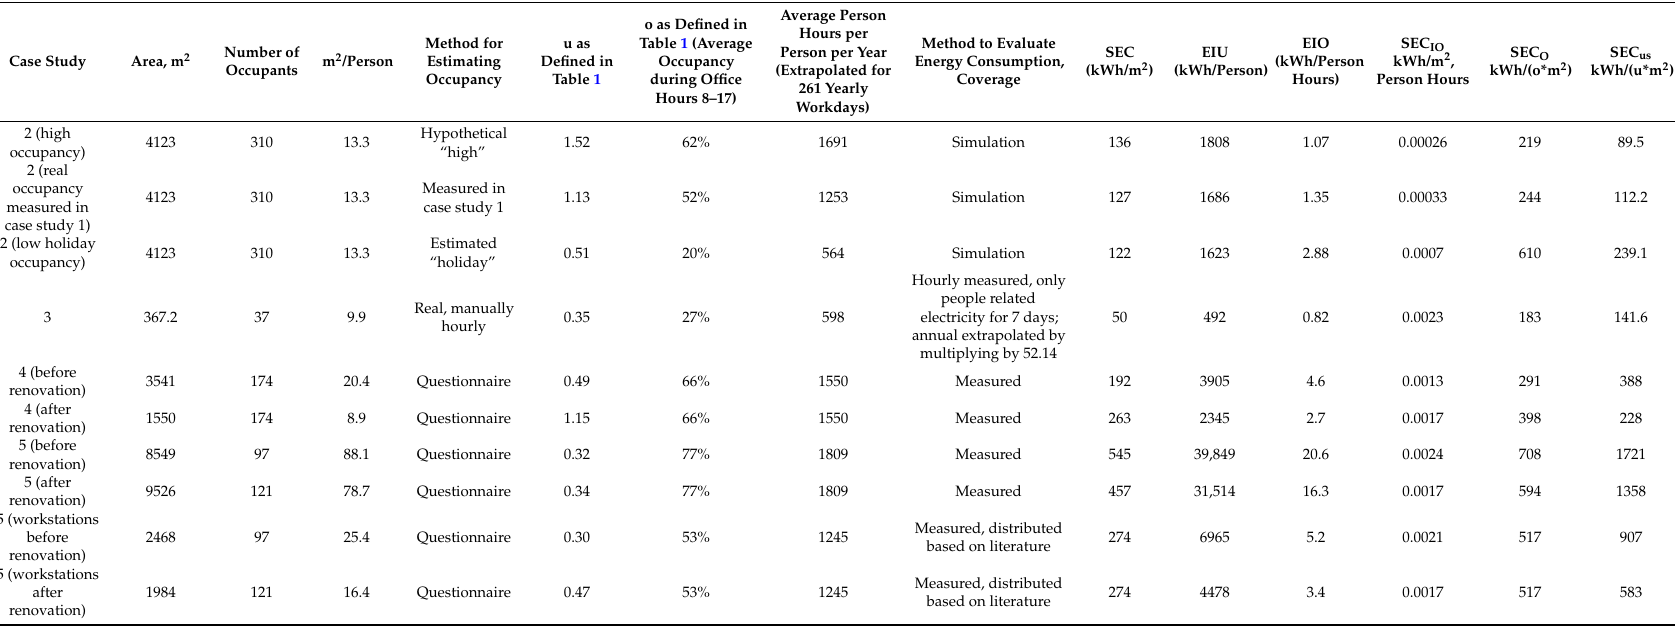
Table 9. Summary of the different indicators in the studied